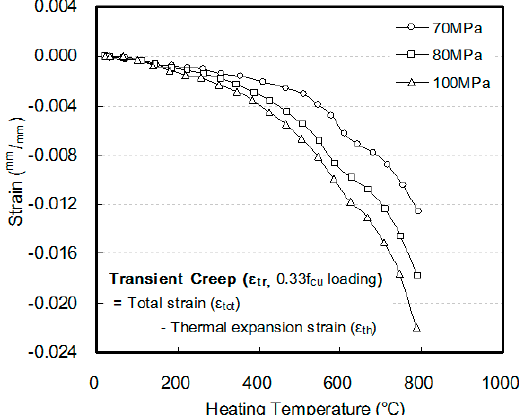
Figure 10. Transient creep of HSC.